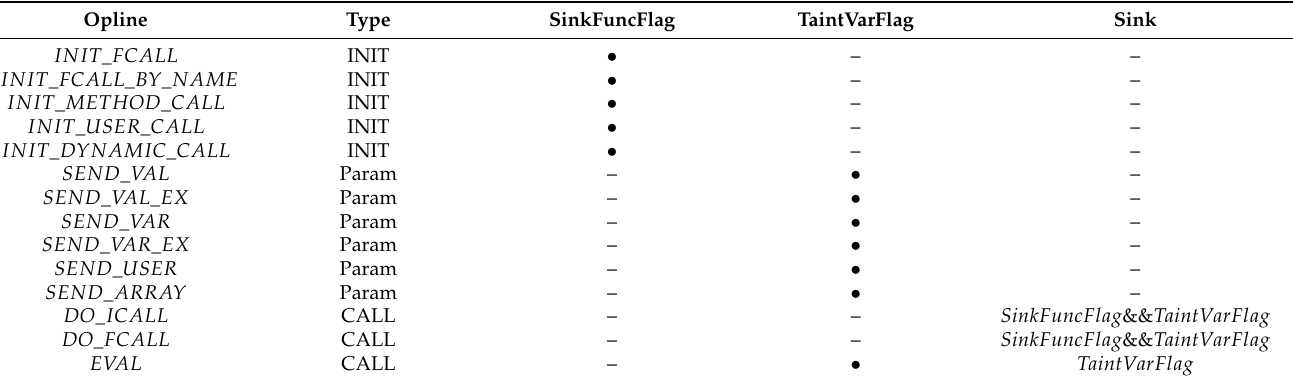
Table 2. Taint sink